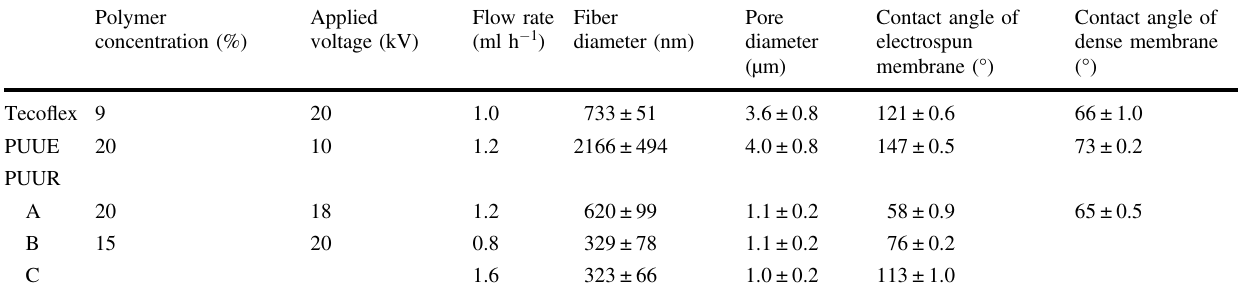
Table 4 Electrospinning conditions and measured parameters Polymer concentration